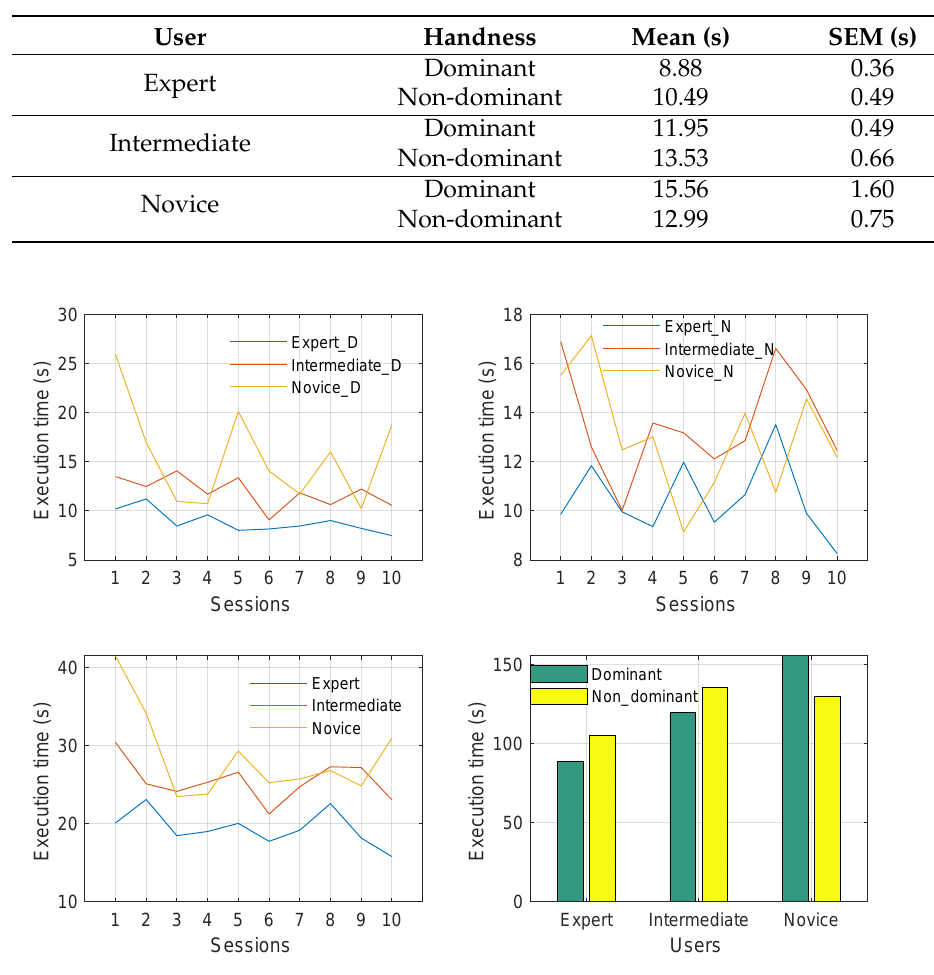
Table 5. Mean and SEM of task execution times across sessions